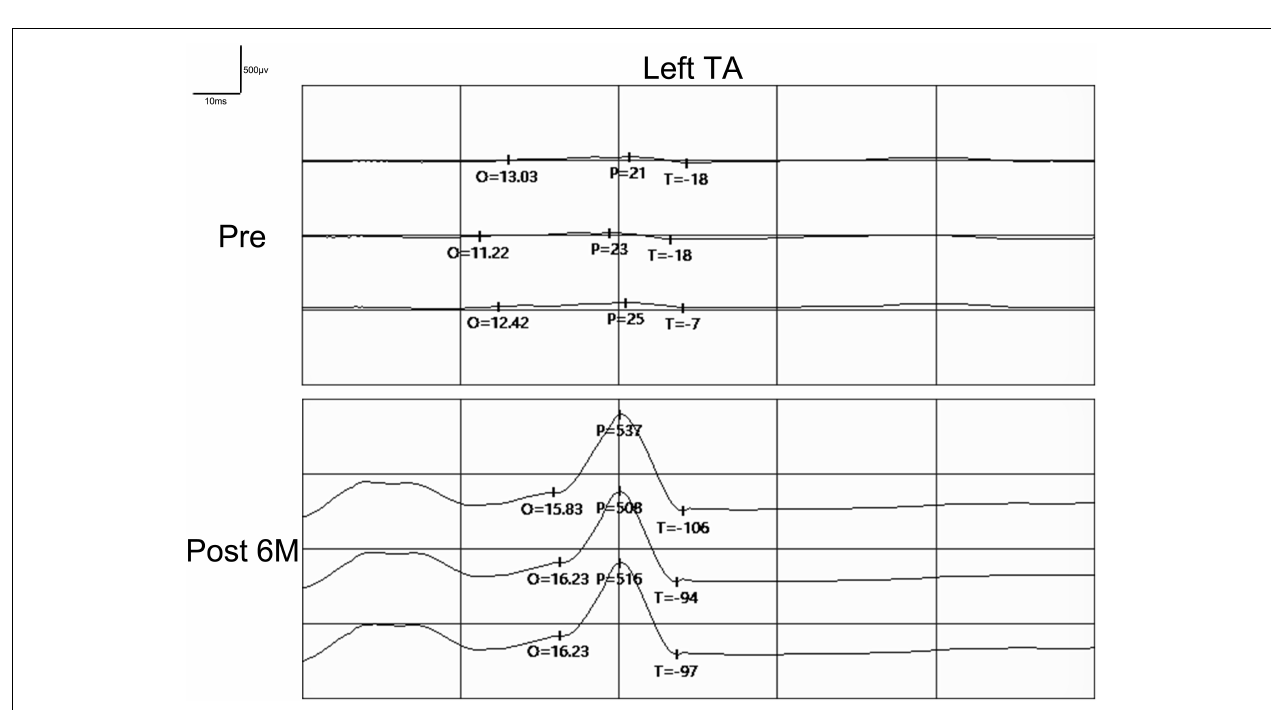
FIGURE 6 | A representative picture of somatosensory evoked potentials (SSEPs) and motor evoked potentials (MEPs) before the surgery in the paraplegic patients. The SSEPs of the bilateral median nerve (MN) were normal. The SSEPs of bilateral posterior tibial nerve (PTA) were missing. MEPs recorded at abductor pollicis brevis (APB) in the bilateral upper extremities were normal. The MEPs recorded at both tibialis anterior (TA) in the bilateral lower extremities were missing.